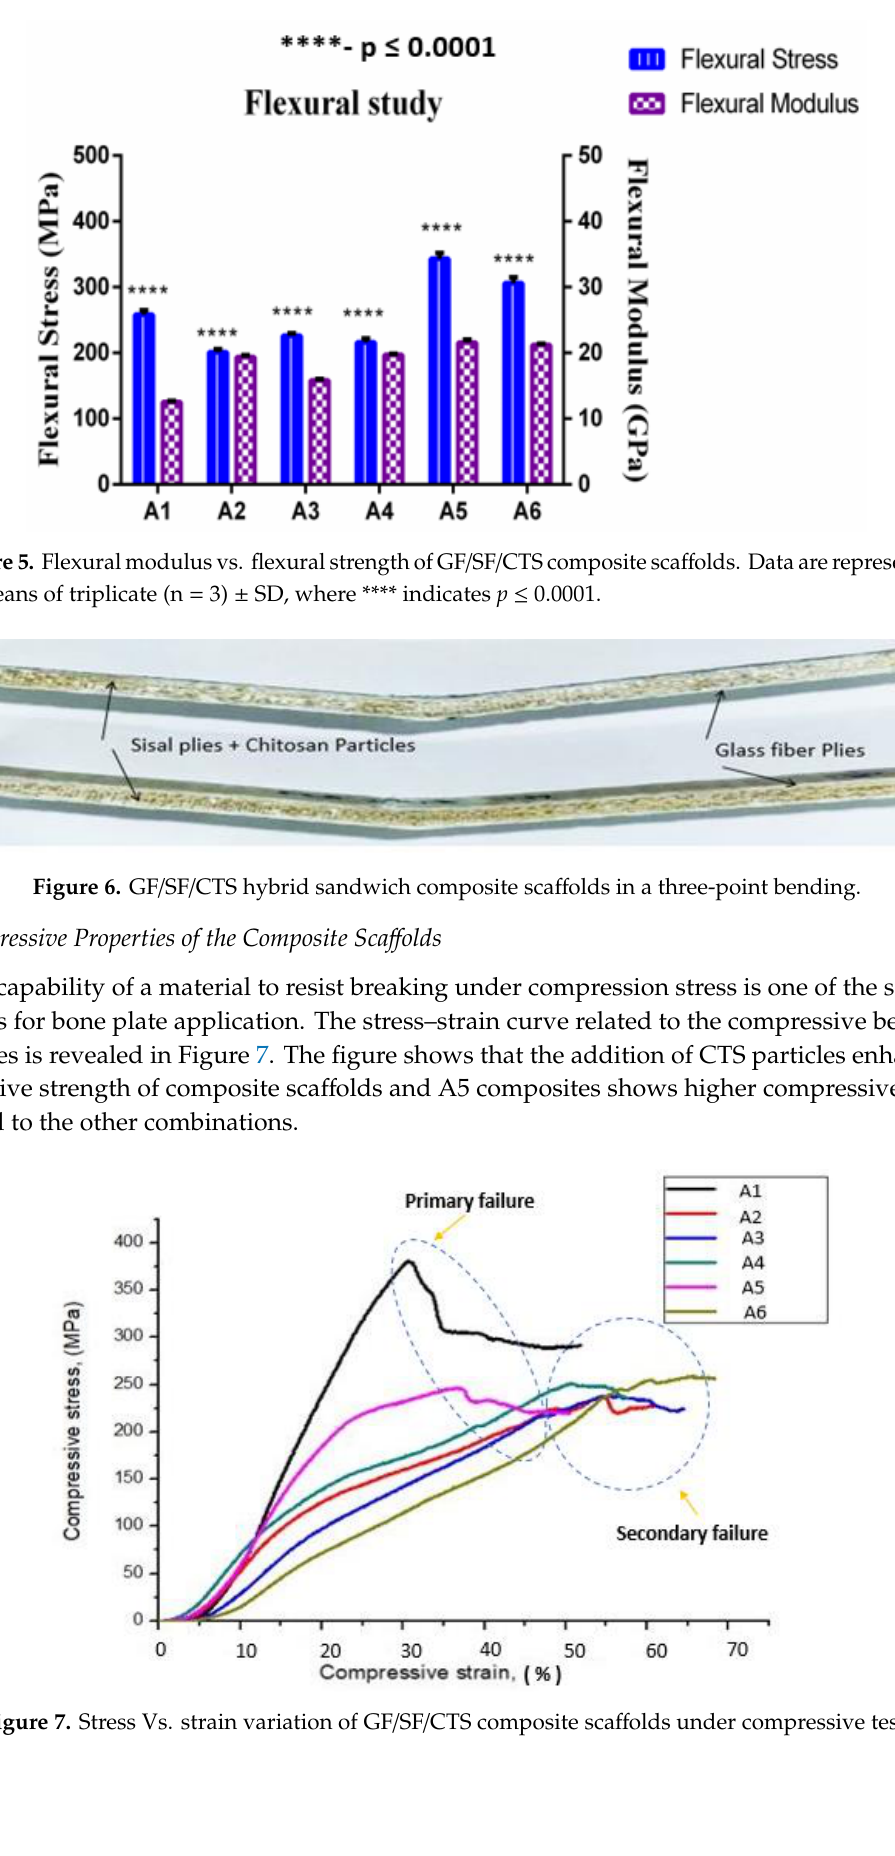
Figure 7. Stress Vs. strain variation of GF/SF/CTS composite scaffolds under compressive test.